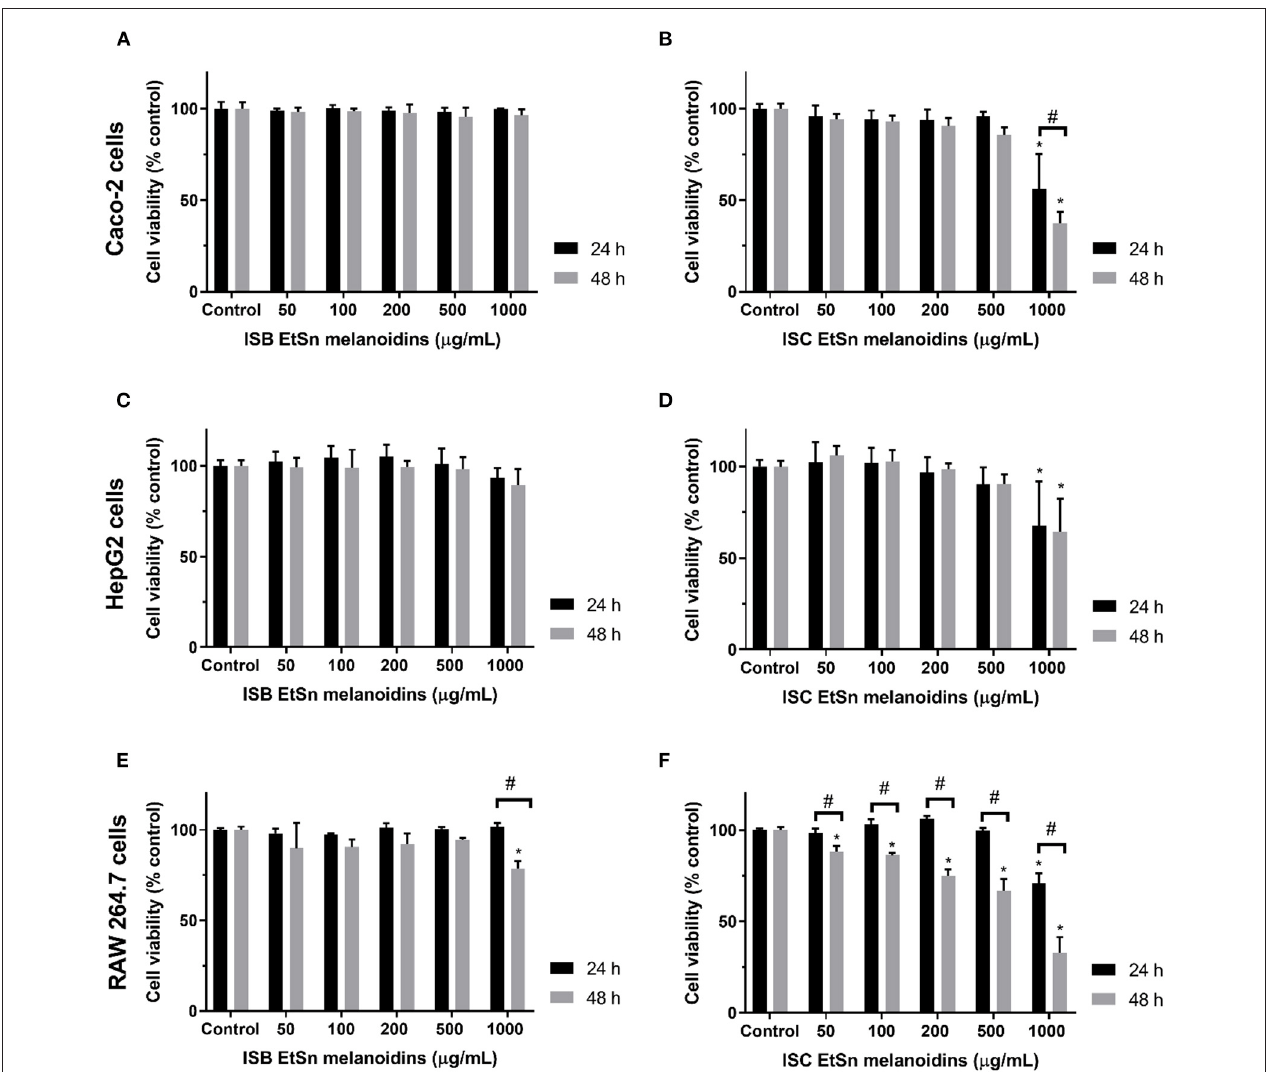
FIGURE 2 | Effect of ISC and ISB EtSn melanoidins on cell viability. Caco-2 (A,B) , HepG2 (C,D) , and RAW 264.7 (E,F) cells were exposed to different concentrations (up to 1 mg/mL, as denoted) of ISC and ISB EtSn melanoidins for 24h (black bars) or 48h (grey bars). Cell viability was assessed using Alamar blue indicator, results are expressed as percentage of control (unexposed cells) and data represent mean ± S.D. ( n = 3 independent experiments, each one with 4 replicates). (*) denotes statistical differences, comparing to respective control. (#) denotes statistical difference, comparing the same concentration between